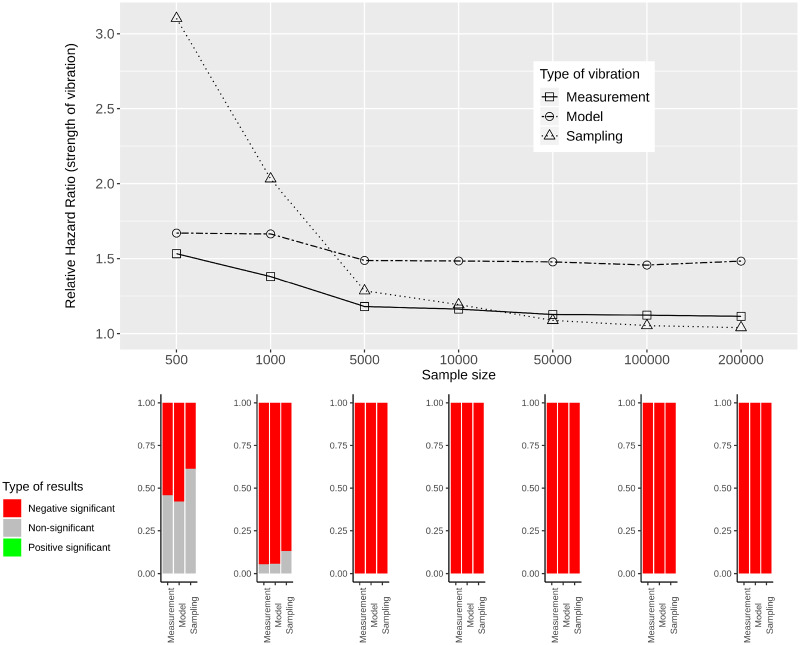
Measurement, model and sampling vibration for different sample sizes (top panel), and bar plots showing the type of results in terms of significance of estimated effects (bottom panel) for the association of thigh circumference with mortality